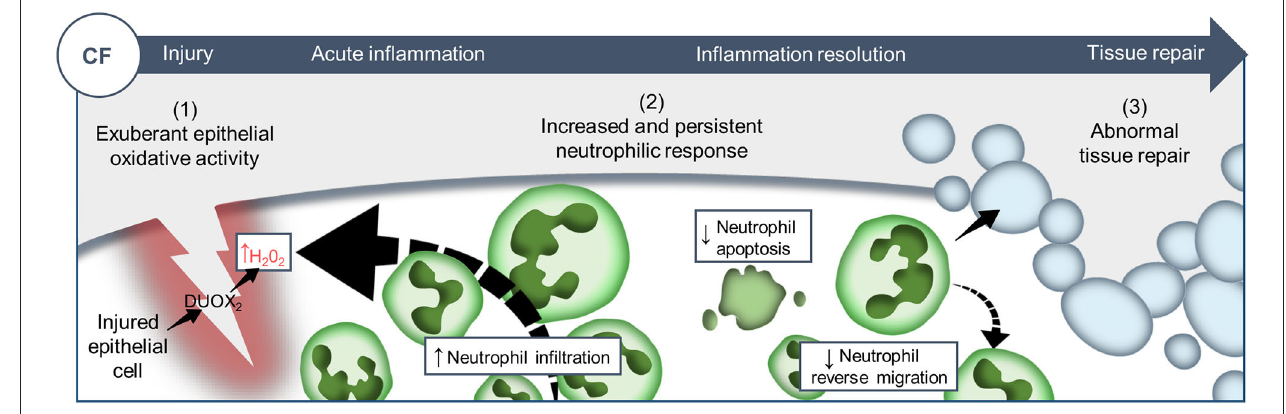
FIGURE 6 | Proposed model showing CF-related inflammation immuno-pathogenesis. The spatiotemporal events associated with CFTR ablation reveal a mechanism whereby CFTR participates in the adjustment of innate immunity, conditioning key regulatory mediators involved in the regulation of inflammation and tissue repair. A sterile lesion is characterized by early release of epithelial H 2 O 2 through DUOX2, leading to neutrophil recruitment towards wounds; coordination of neutrophil apoptosis and reverse migration promoting efficient inflammation resolution, and allowing to restore tissue homeostasis and initiate tissue repair. In contrast, in CF zebrafish sterile injury leads to extensive inflammation, typified by increased then sustained accumulation of neutrophils at wounds: (1) excessive epithelial ROS release drives increased neutrophil recruitment towards wounds; (2) reduction of neutrophil apoptosis and impaired retrograde migration of neutrophils resulting in delayed resolution of inflammation. (3) Therefore, the increased number of neutrophils that mobilize in an uncontrolled manner at wound sites causes persistent inflammation, severe tissue damage, and abnormal tissue